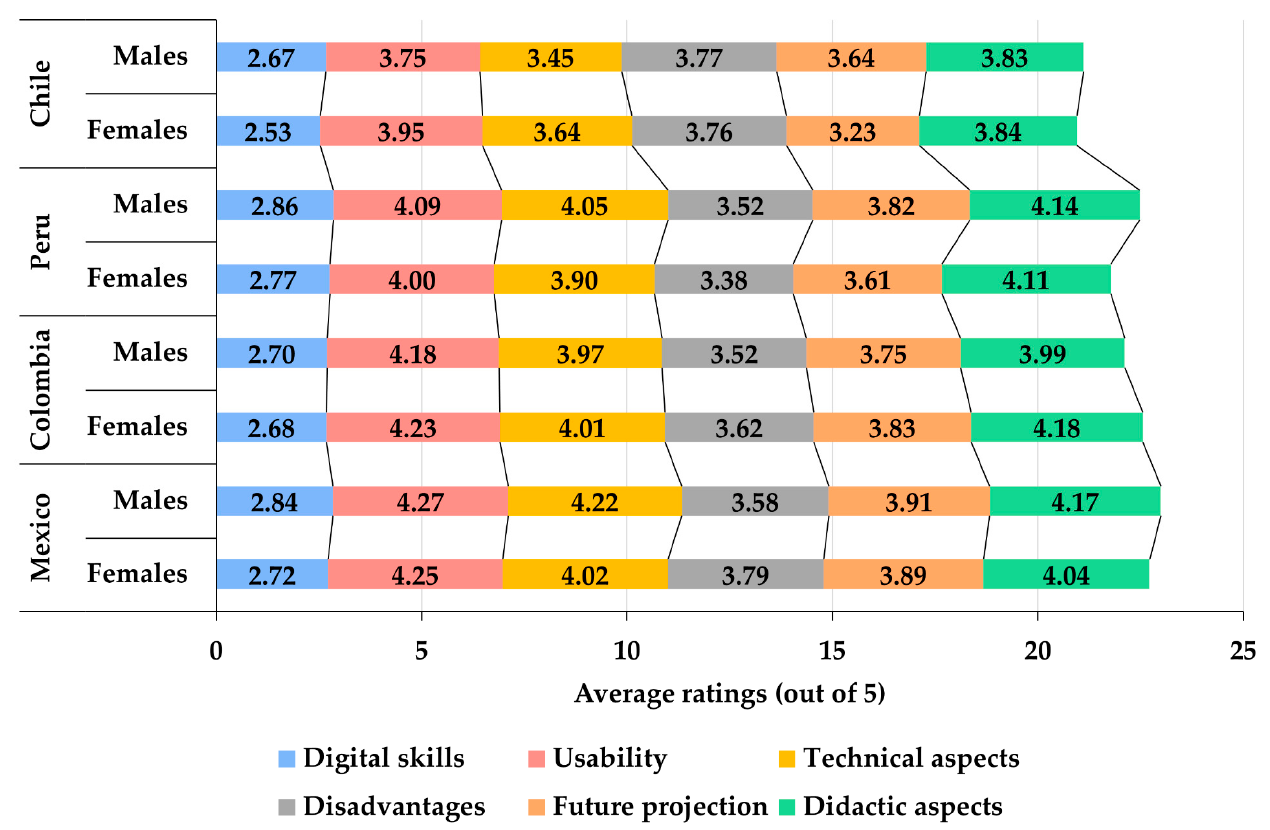
Figure 3. Average responses (out of 5) differentiating by country and gender.